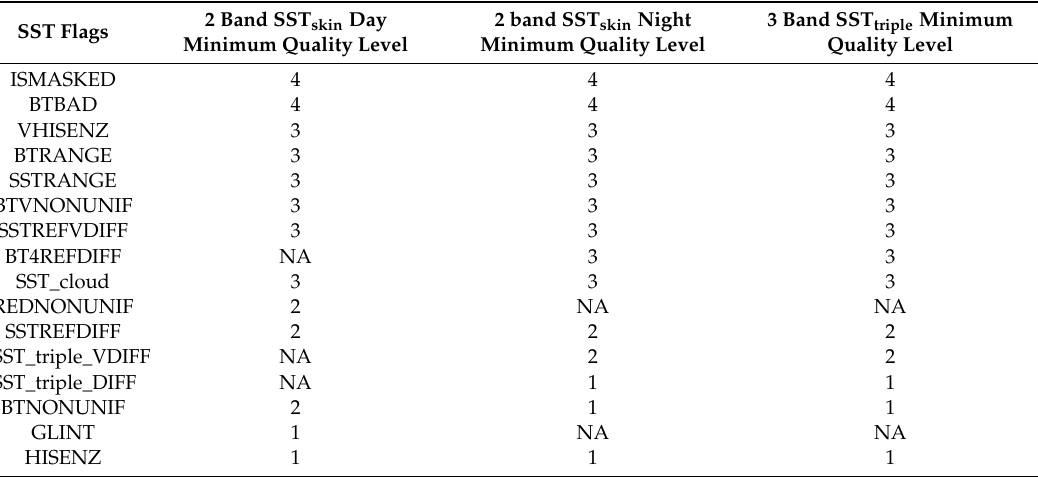
Table A2. Quality tests combinations used to set quality